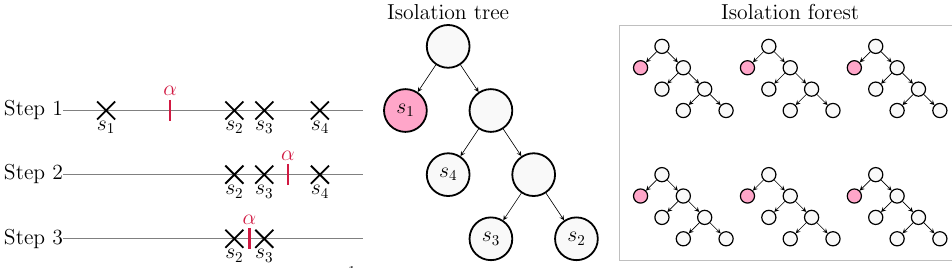
Figure 4. Isolation forest example with |D| =